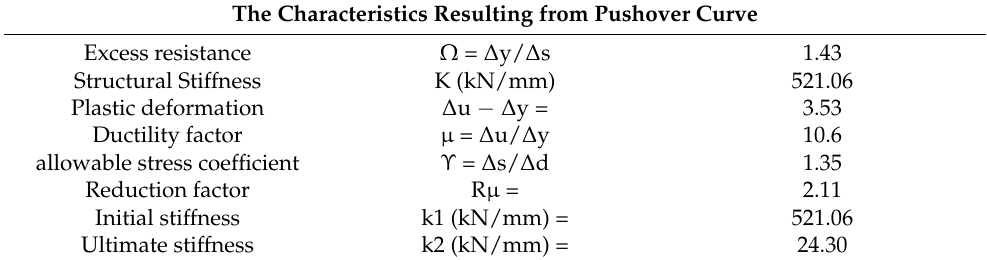
Table 6. The characteristics resulting from pushover